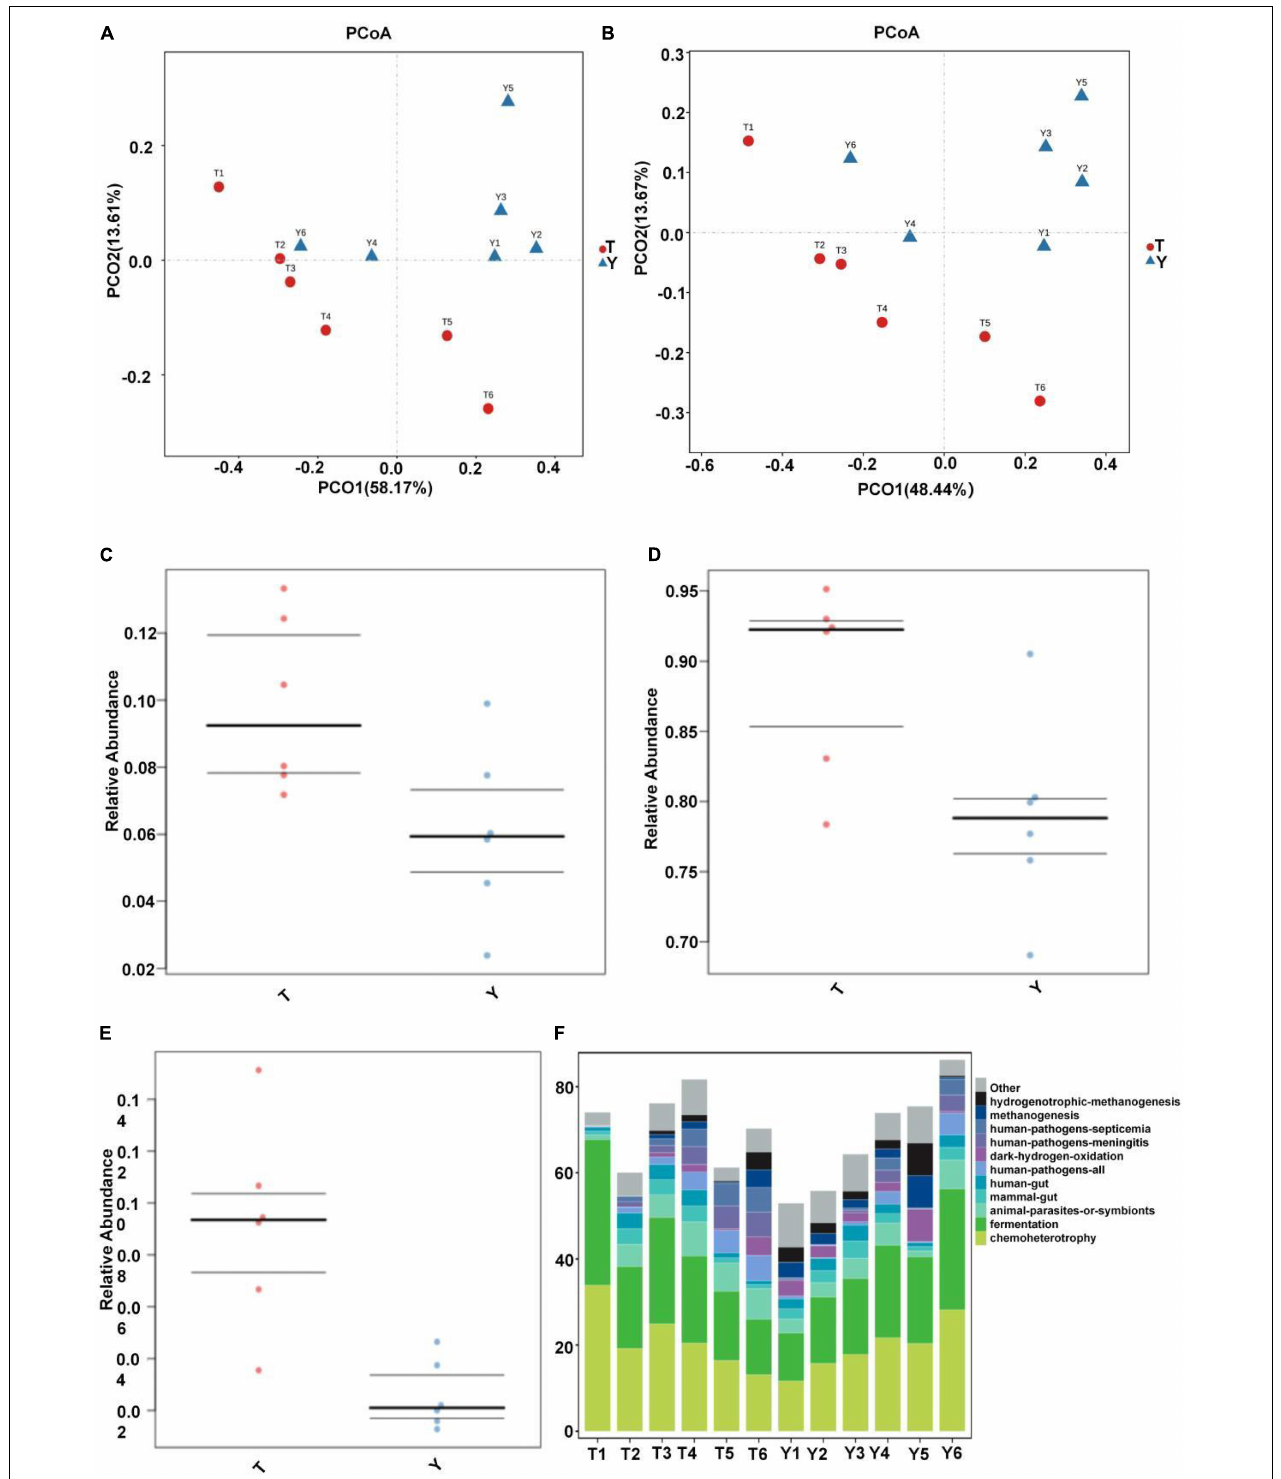
FIGURE 7 | Prediction of ecological functions performed by intestinal microbiota of Tibetan (T) and Yorkshire (Y) pigs. Principal component analysis of group T and group Y at family (A) and genus (B) levels. Each point represents a sample. Distance between the two points indicates difference in fecal microbiota. Transmembrane transport (C) , potential pathogenicity (D) , and aerobic activity (E) are some of the predicted ecological functions of the intestinal microbiota in both groups (F) .